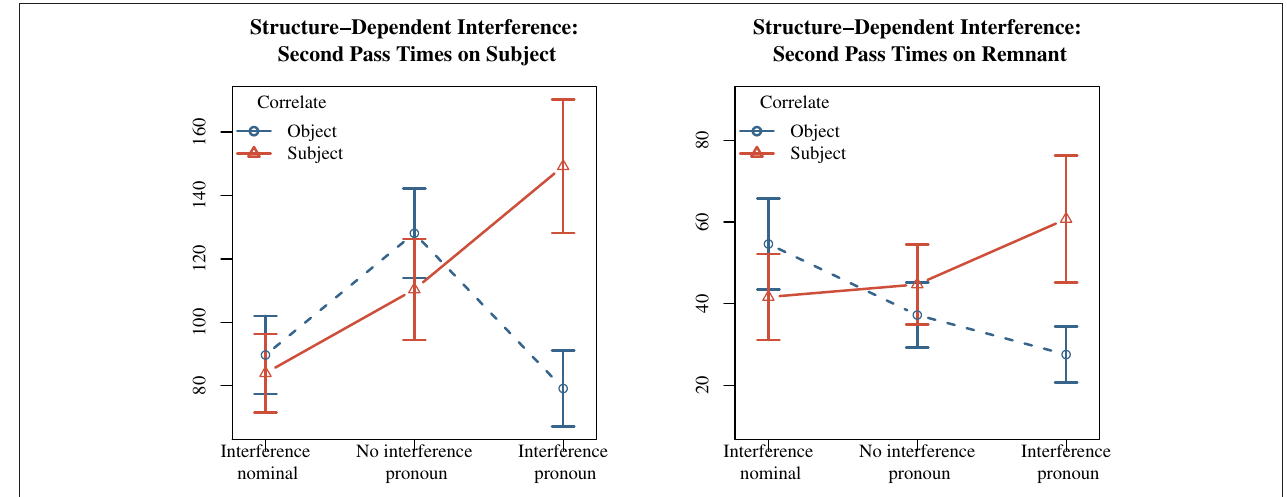
FIGURE 3 | Experiment 2: Structure-Dependent Interference effects on subject and remnant regions. Times presented in ms.